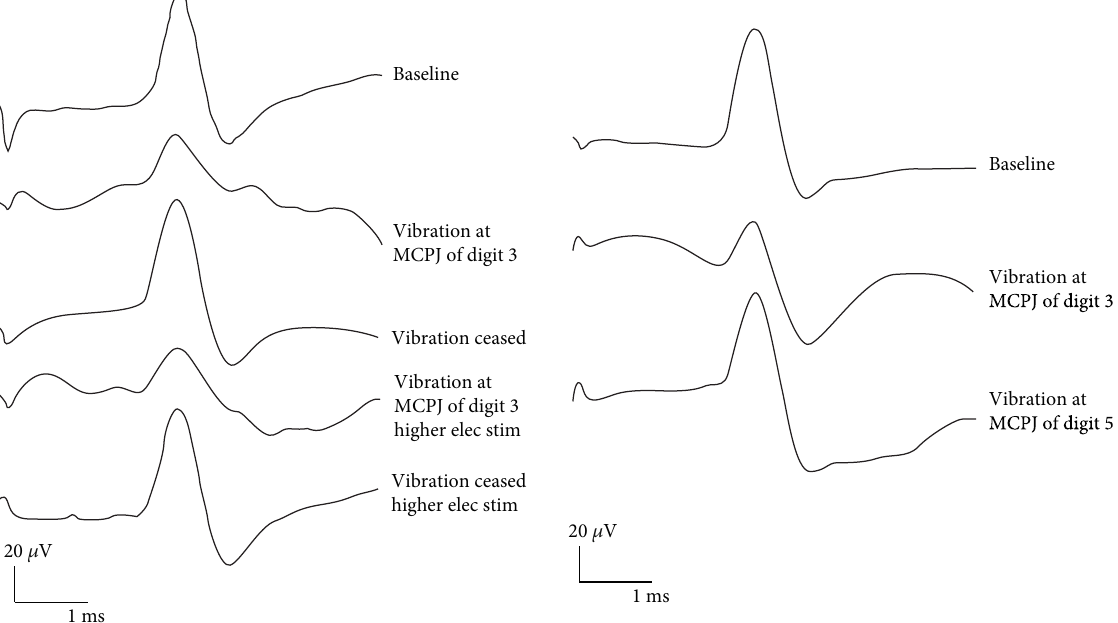
Figure 2: Digit 3 SNAP. (a) Recordings from subject 14, the amplitude of SNAP reduces with the similar extent (52.4.0% vs. 54.1%) at the two di ff erent stimulation intensities. The SNAP amplitude regains its baseline value after vibration. (b) Recordings from subject 3, illustrating a smaller reduction of digit 3 SNAP amplitude when vibration applied to the MCPJ of digit 5 (62.9%) in comparison with the greater reduction when vibration to the MCPJ of digit 3 (31.5%). No notable changes of the onset latencies during or after